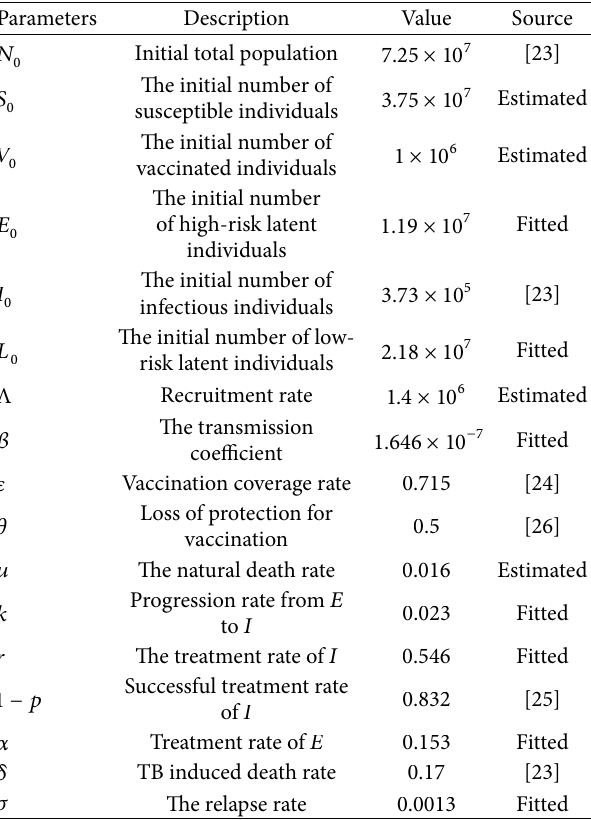
Table 1: The parameter values of the model